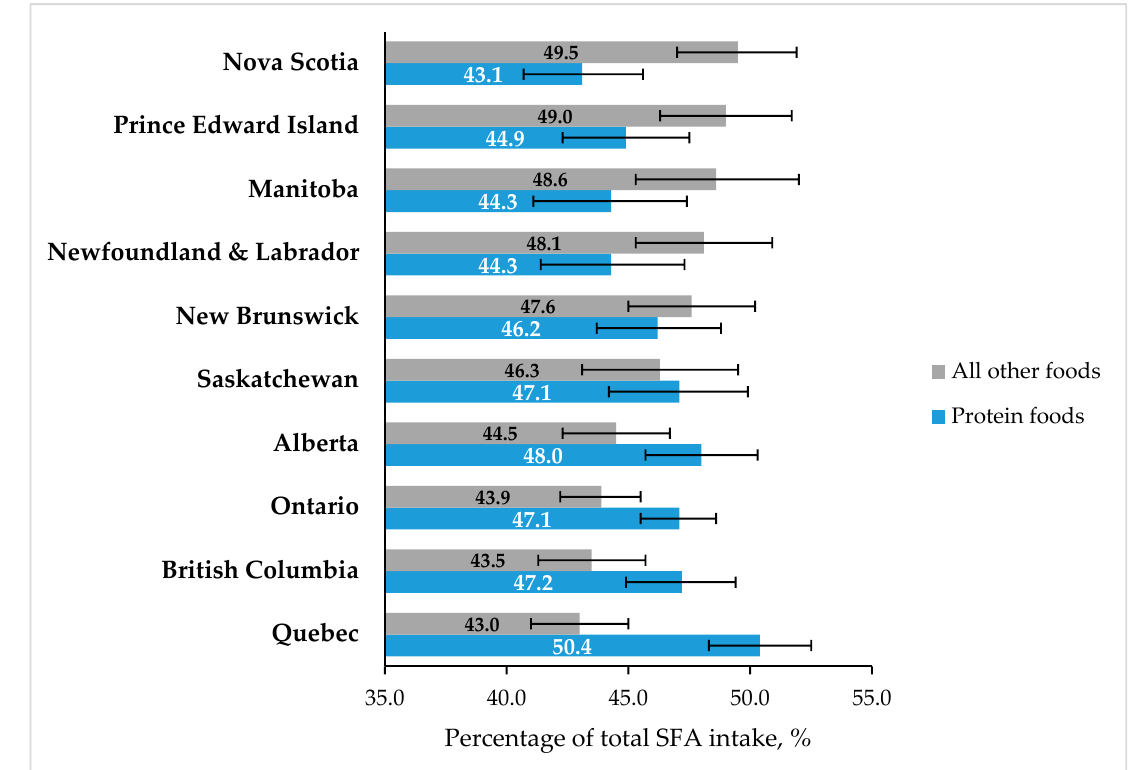
Figure 2. Proportion of total SFA intake from the “All other foods” and “Protein foods” categories, according to province of residence.